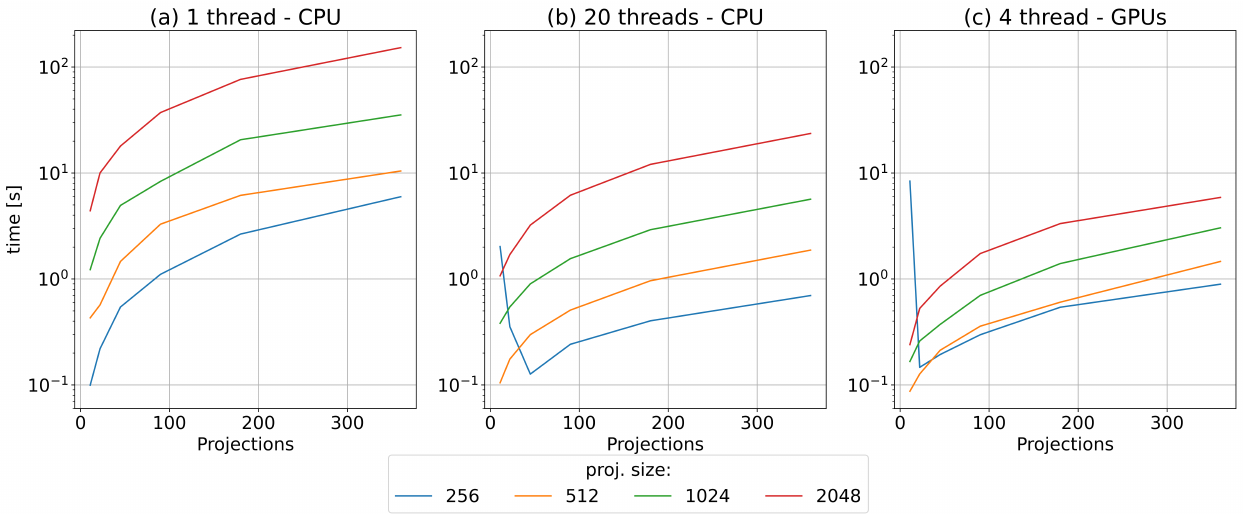
Figure 5. Performance comparison for the registration module, shown for single-thread (first column), 20 threads (centre column), and a multi-GPU implementation (third column). The performance gain in terms of speed is large even for the CPU-only multi-threaded